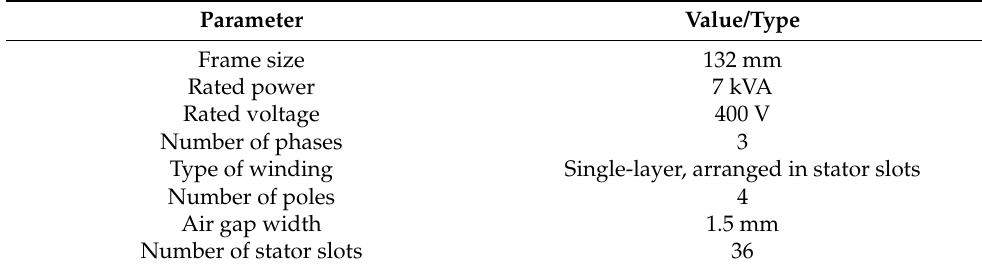
Table 1. List of parameters of the considered electric